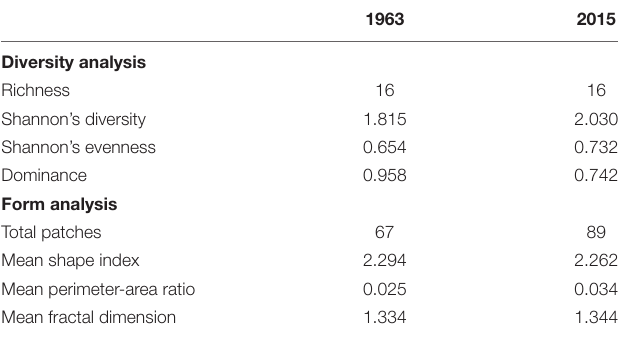
TABLE 3 | Diversity and form analysis at a landscape